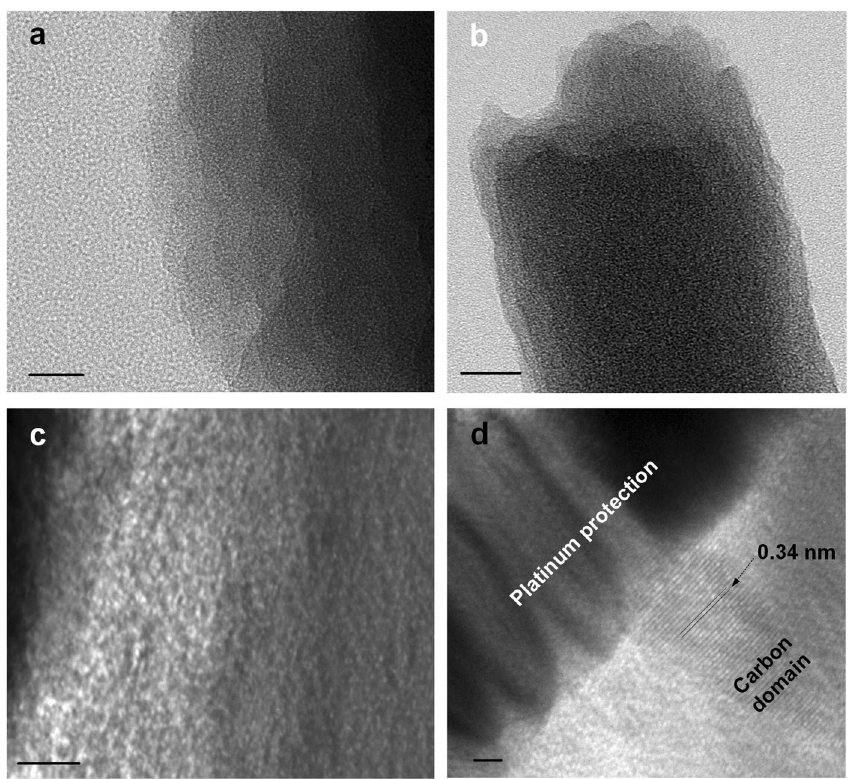
Fig. 4 TEM micrographs of the PAN nano fi bers pyrolyzed at 600 and 950 °C. a , b TEM images of the broken edges of the nano fi bers pyrolyzed at 600 and 950 °C respectively, showing the presence of several sheath layers. c Cross-section high-resolution TEM micrograph of the nano fi ber pyrolyzed at 600 °C does not reveal any graphitic crystal domain formation. d Cross-section TEM micrograph of the nano fi ber pyrolyzed at 950 °C showing the presence of lattice structures. Scale bars ( a , b ) = 20 nm; ( c ) = 5 nm; ( d ) = 2